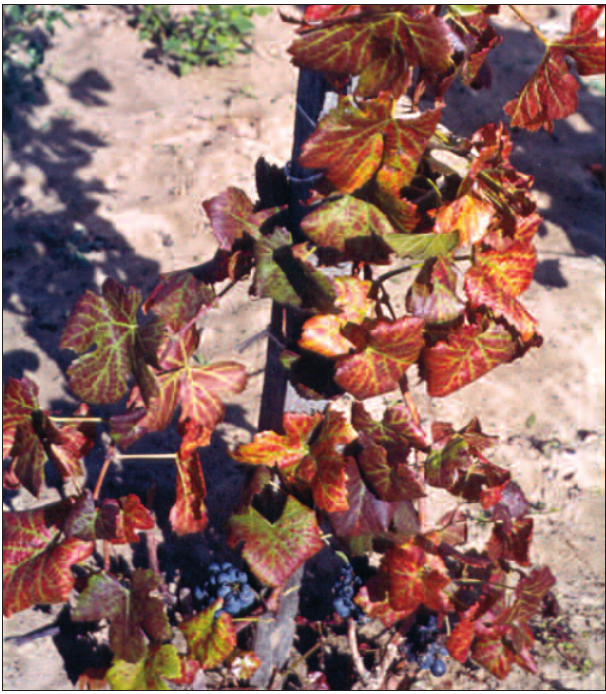
Figure 8. Leafroll (GLRaVs) – typical symptoms on leaves of white varieties: rolling and